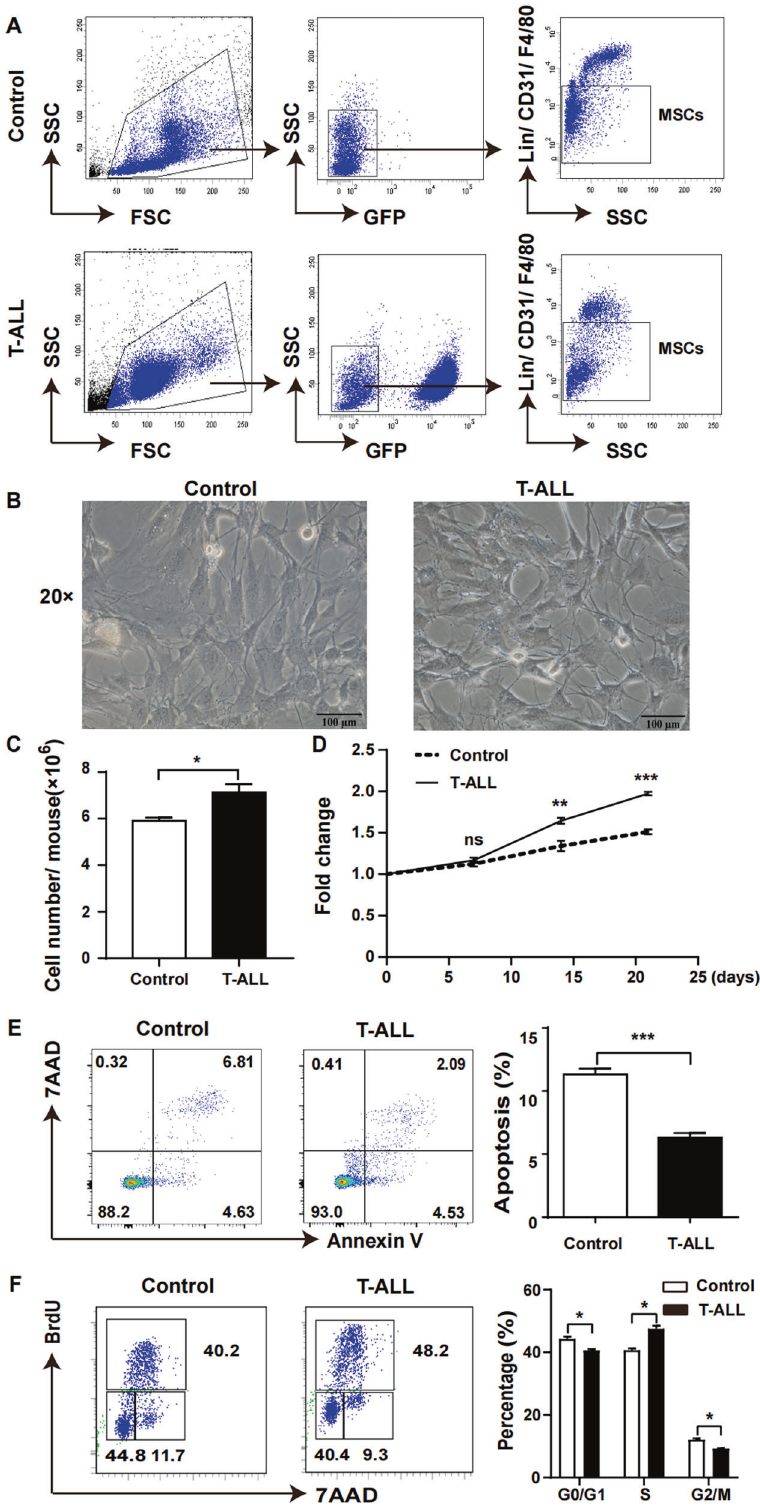
Fig. 1 Dynamic alterations of MSCs in leukaemia niche. On day 10 after model establishment, the mice were killed and BM cells were obtained by fl ushing ilias, femurs and tibias. A FACS analysis of MSCs (GFP - /Lin - /CD45 - /CD31 - /F4/80 - ) from leukaemia and control mice. GFP negative selection was used to remove leukaemia cells, while CD45 and lineage were used to remove haematological cells. CD31 was used to remove endothelial cells and F4/80 was used to exclude macrophages. B Morphology images of MSCs isolated by FACS from leukaemia and control mice and then cultured in vitro for 14 days with DMEM. C The absolute number of MSCs from leukaemia mice was higher compared to control. D In vitro growth curve showed that the growth of leukaemia-derived MSCs was signi fi cantly faster compared to MSCs from control mice. E The apoptosis rate of leukaemia-derived MSCs was decreased compared to MSCs from control mice. F More leukaemia-derived MSCs got into S phase compared to MSCs from control mice. ( n ≥ 3, * P < 0.05, ** P < 0.01, *** P < 0.005). Cell Death and Disease (2022)